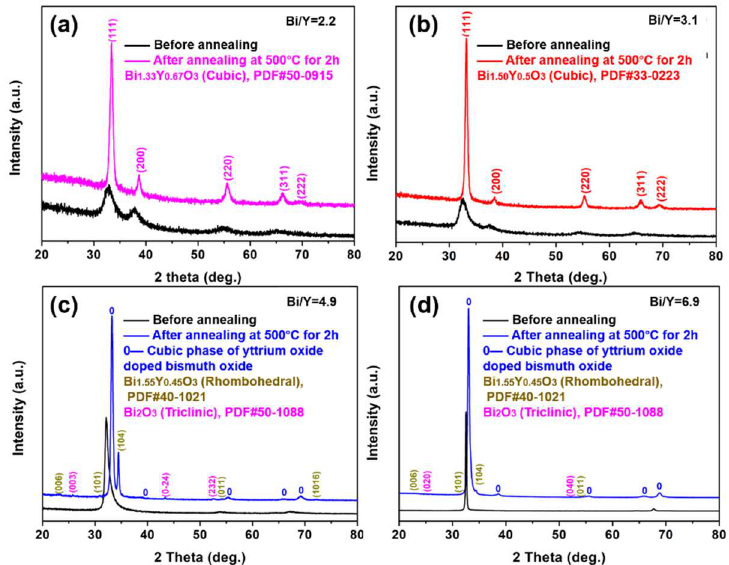
Figure 3. XRD characterization of films deposited on glass with different atomic ratios of ( a ) Bi/Y = 2.2, ( b ) Bi/Y = 3.1, ( c ) Bi/Y = 4.9, ( d ) Bi/Y = 6.9.